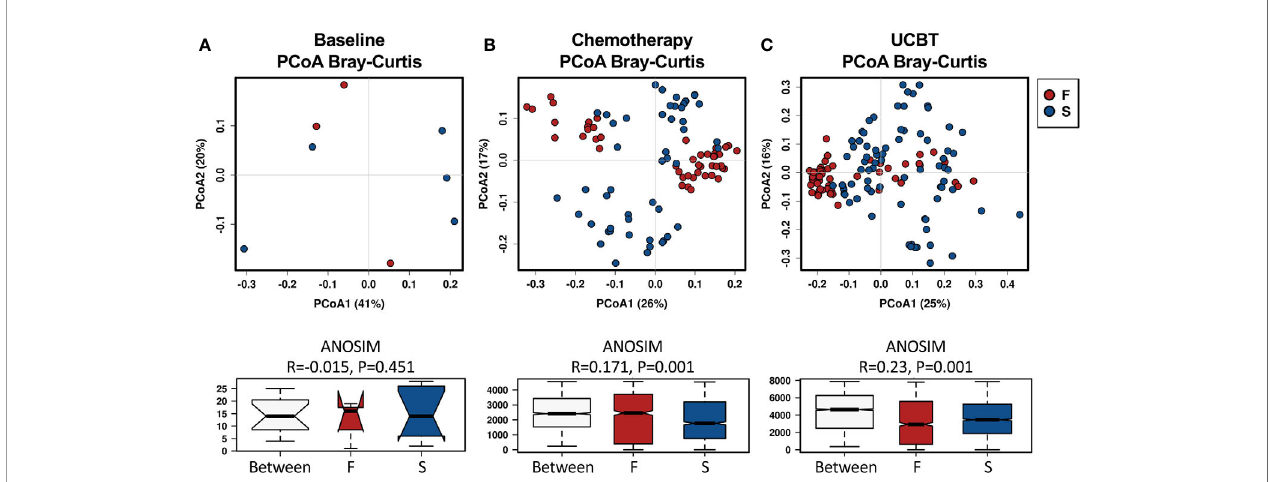
FIGURE 1 | Principal coordinate analysis (PCoA) of the beta-diversity differences based on Bray-Curtis distances between the F and S groups during the treatment course. Groups were indicated in different colors. (A) Baseline. (B) Chemotherapy. (C) During